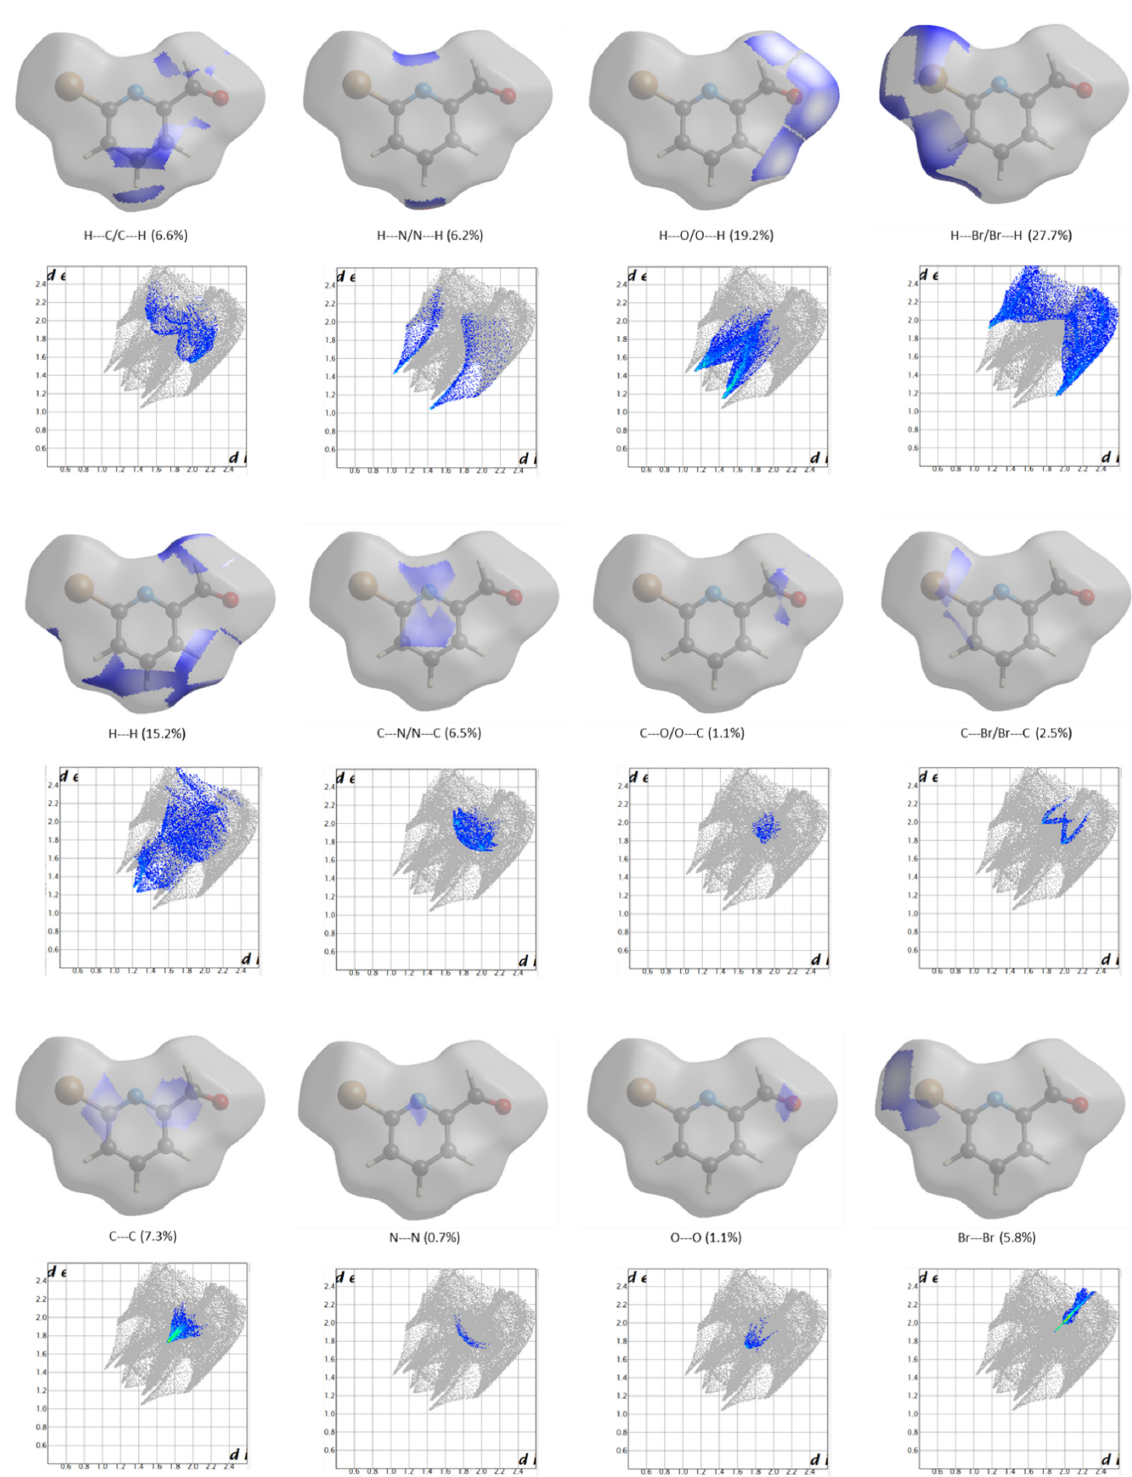
Figure 6. Three-dimensional d norm maps on the Hirshfeld surface of the asymmetric unit cell of crystalline BPCA [14] and the corresponding 2D fingerprint plots ( d e vs. d i ), showing the most relevant types of short contacts present in the crystal. Fractional areas (in %) of the Hirshfeld surface assigned to the different intermolecular contacts are also provided in the figure, corresponding to the blue areas in the